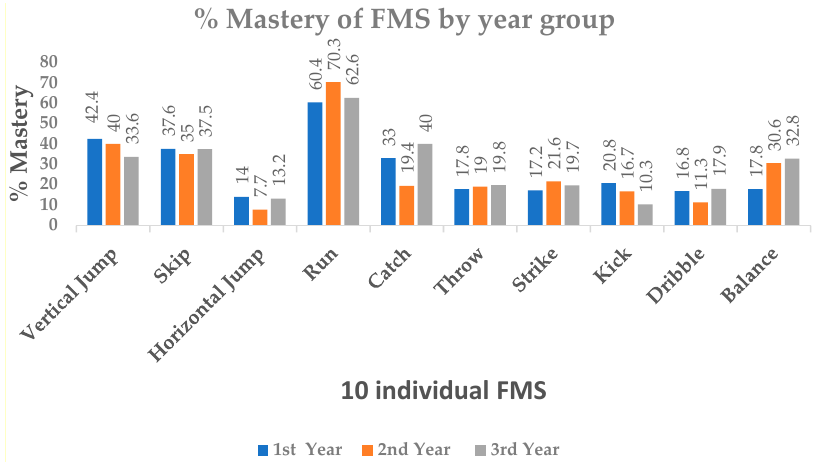
Figure 1. The prevalence of fundamental movement skills (FMS) mastery by school year group among participants. Table 1. Actual FMS and FMS TM proficiency by year group (ANOVA results). FMS Skills (Max Raw